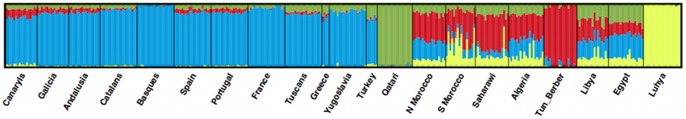
Results of the ADMIXTURE analysis (k = 4) with North African populations.ADMIXTURE was performed on a set of European, North African, Near Eastern and Sub-Saharan populations in order to account for the different admixture proportions in North Africa. Tunisians and Saharawi are the North African populations with highest proportion of autochthonous component, whereas the rest of the populations have greater amounts of admixture with neighboring populations.